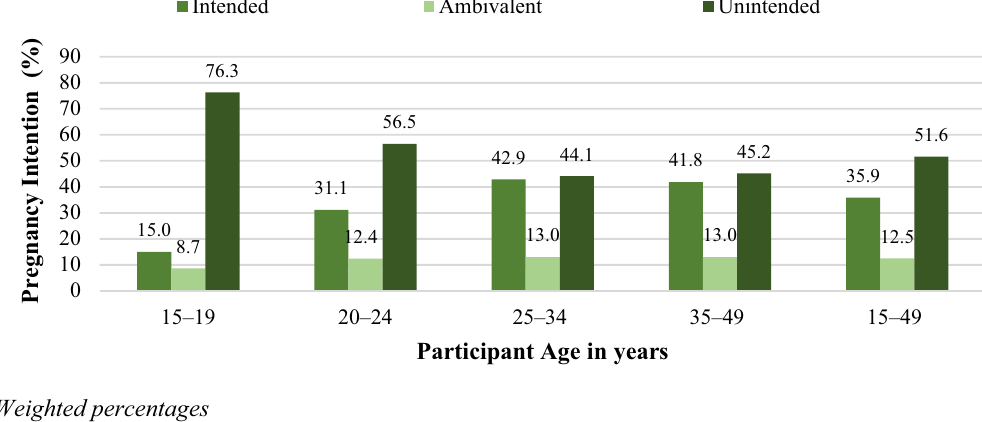
Figure 1. Pregnancy intention by age group in the 2019 Antenatal HIV Sentinel Survey, South Africa.